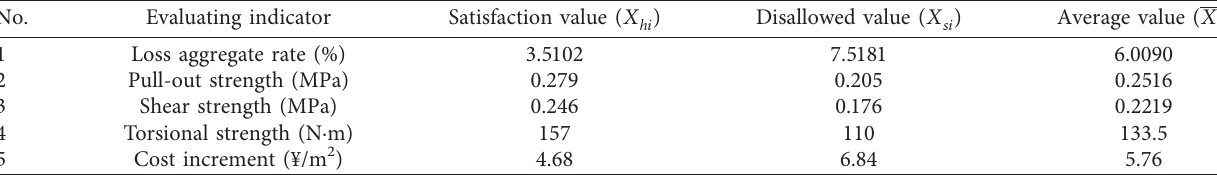
Table 6: Standardization of evaluation index